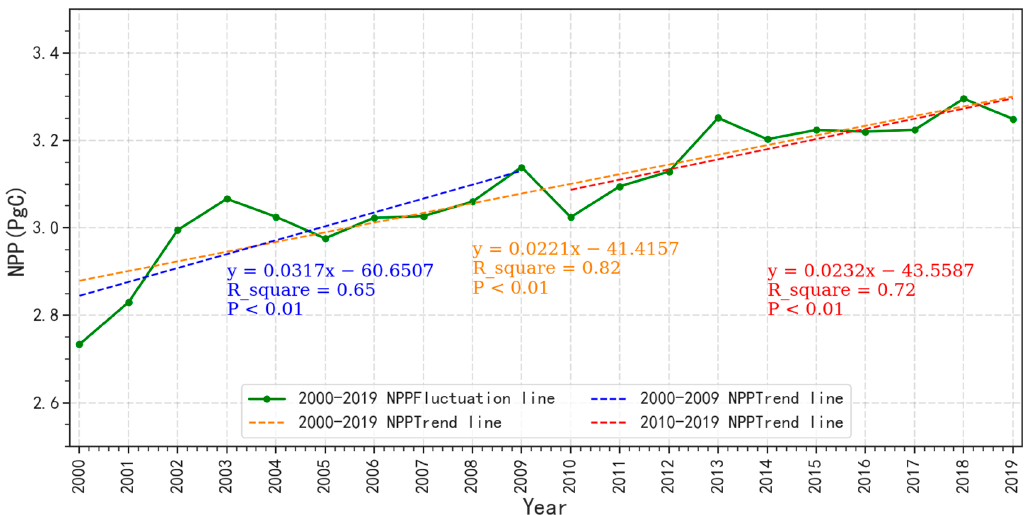
Figure 7. Interannual changes in China’s vegetation NPP from 2000 to 2019.